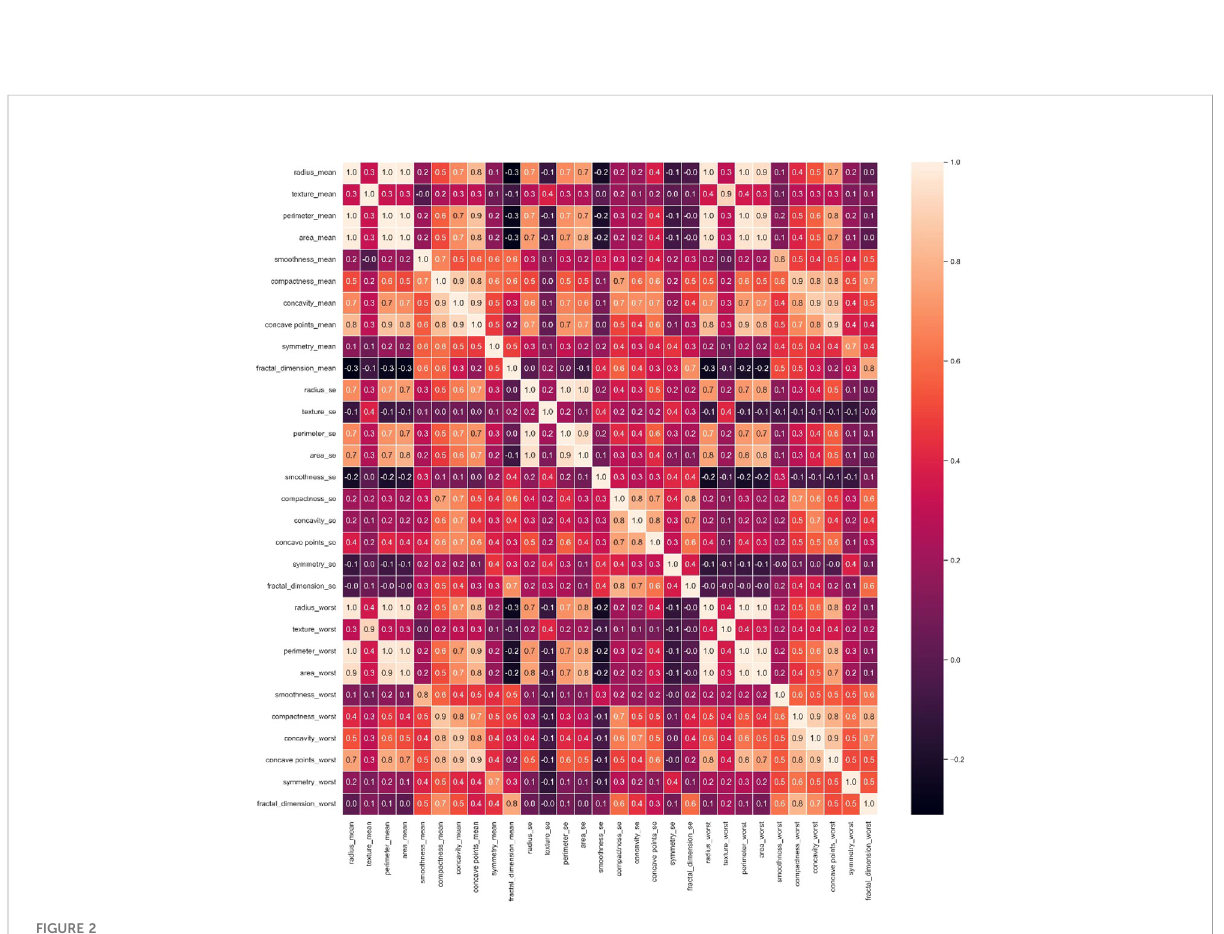
FIGURE 2 Breast cancer correlation heatmap.